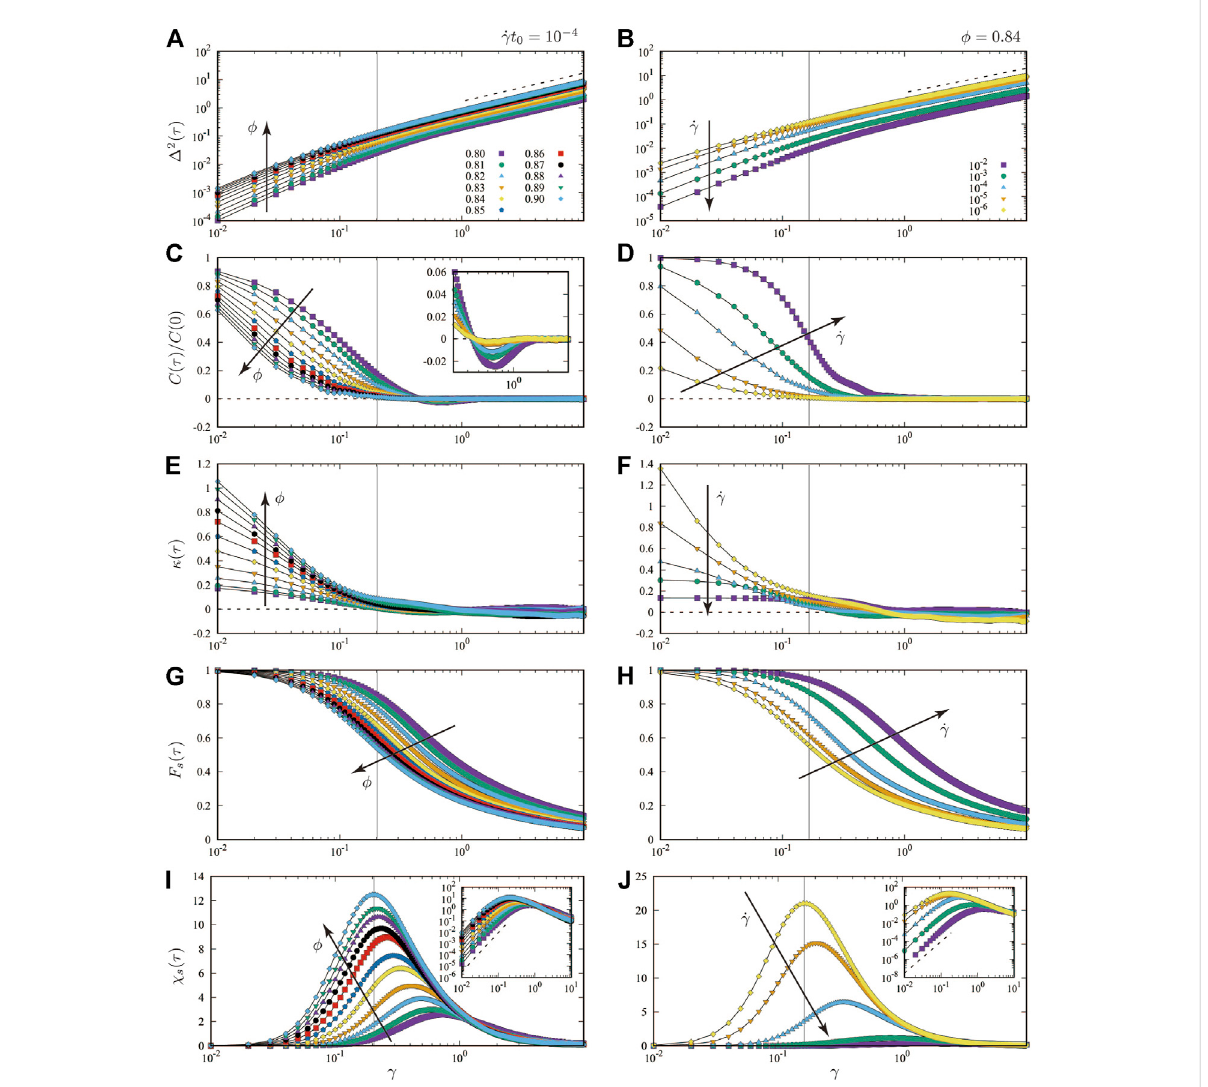
FIGURE 2 The MSD Δ 2 ( τ ) ( (A) and (B) ), normalized VACF C ( τ )/ C (0) ( (C) and (D) ), non-Gaussian parameter κ ( τ ) ( (E) and (F) ), self-intermediate scattering function F s ( τ ) ( (G) and (H) ), and dynamic susceptibility χ s ( τ ) ( (I) and (J) ) as functions of the shear strain γ (cid:2) _ γτ , where we used the model A for the damping force (see the SM [41]for theresults of model B). In (A) , (C) , (E) , (G) , and (I) , we increase thepacking fraction of the particles ϕ as listed inthe legend of (A) , where the scaled shear rate is given by _ γ t 0 (cid:2) 10 − 4 . In (B) , (D) , (F) , (H) , and (J) , we decrease the scaled shear rate _ γ t 0 as listed in the legend of (B) , where the packing fraction is fi xed to ϕ = 0.84. The dashed lines in (A) and (B) indicate the normal diffusion, Δ 2 ~ _ γτ , while those in (C) – (F) representzero.Theinsetto (C) isazoom-intothedatafor ϕ < ϕ J ≃ 0.8433and _ γ t 0 (cid:2) 10 − 4 .Theinsetsto (I) and (J) aredoublelogarithmicplots, where the dashed lines indicate the power-law behavior (with the slope 3.5). The vertical solid lines represent the peak positions of the